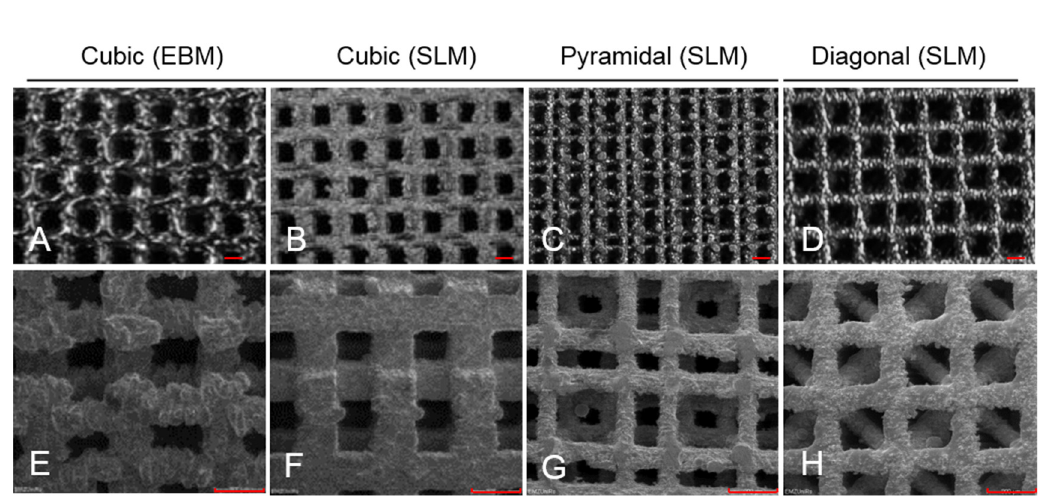
Figure 2. Light microscope ( A – D ; scale bar: 700 µm) and scanning electron microscope pictures ( E – H ; scale bar: 900 µm) of the Ti-6Al-4V scaffolds with four basic structures and fabricated with two different processes (EBM: electron beam melting; SLM: selective laser melting).